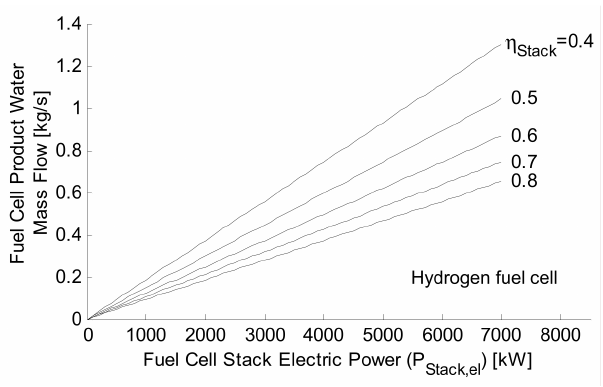
Figure 3. Product water mass flow obtainable from hydrogen